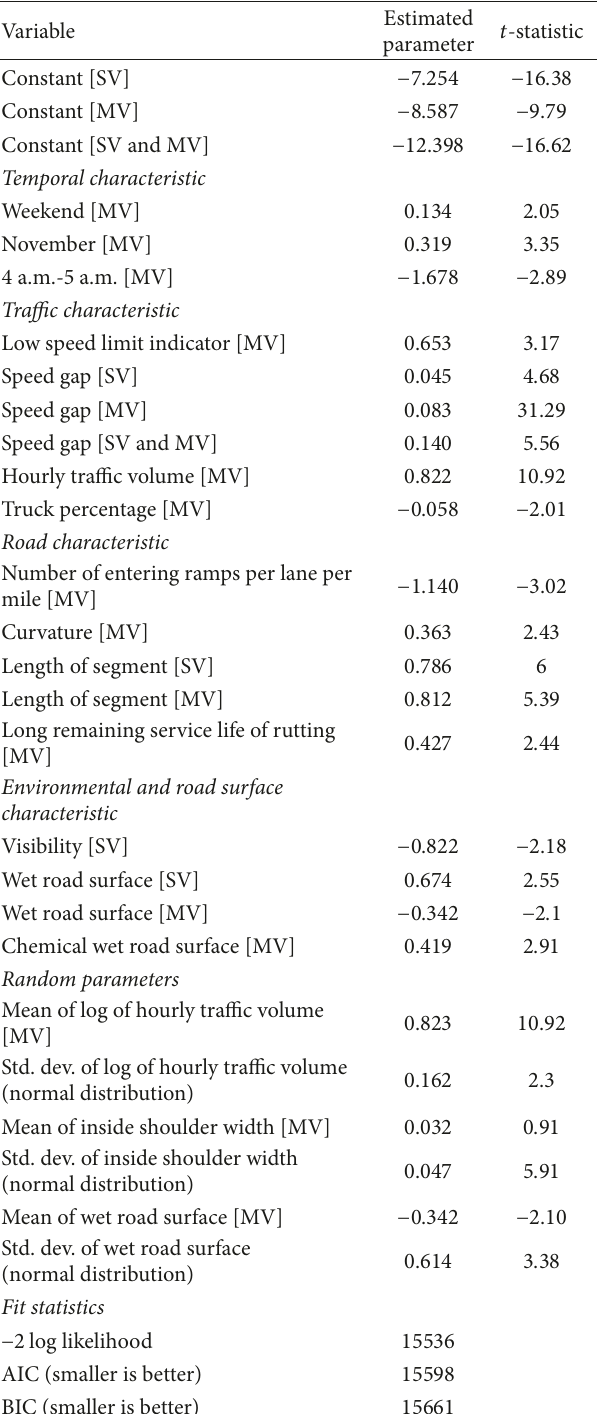
Table 3: The estimated results of mixed logit model with four crash categories.